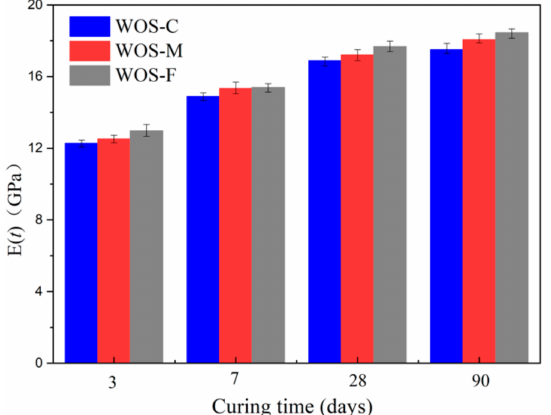
Figure 10. The effect of particle size on the static elastic modulus.